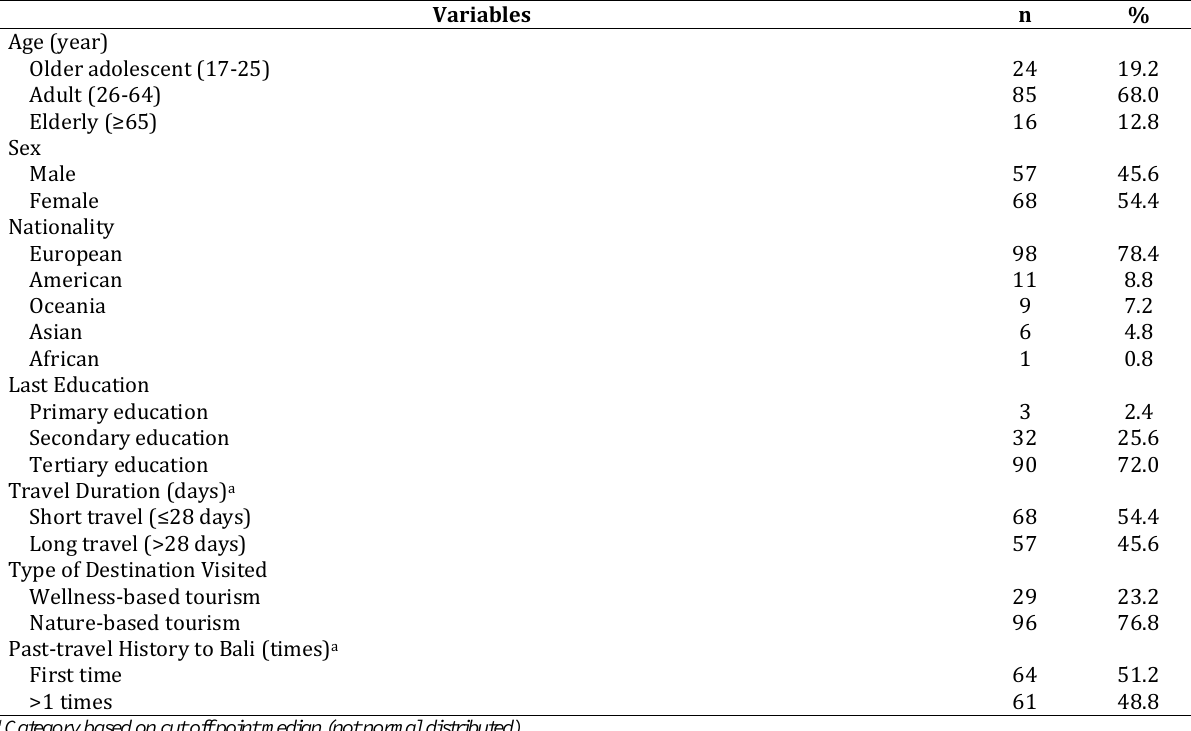
Table 1. The Sociodemography and Itinerary Characteristics of International Travelers in Badung, Bali in 2020 (n=125 )